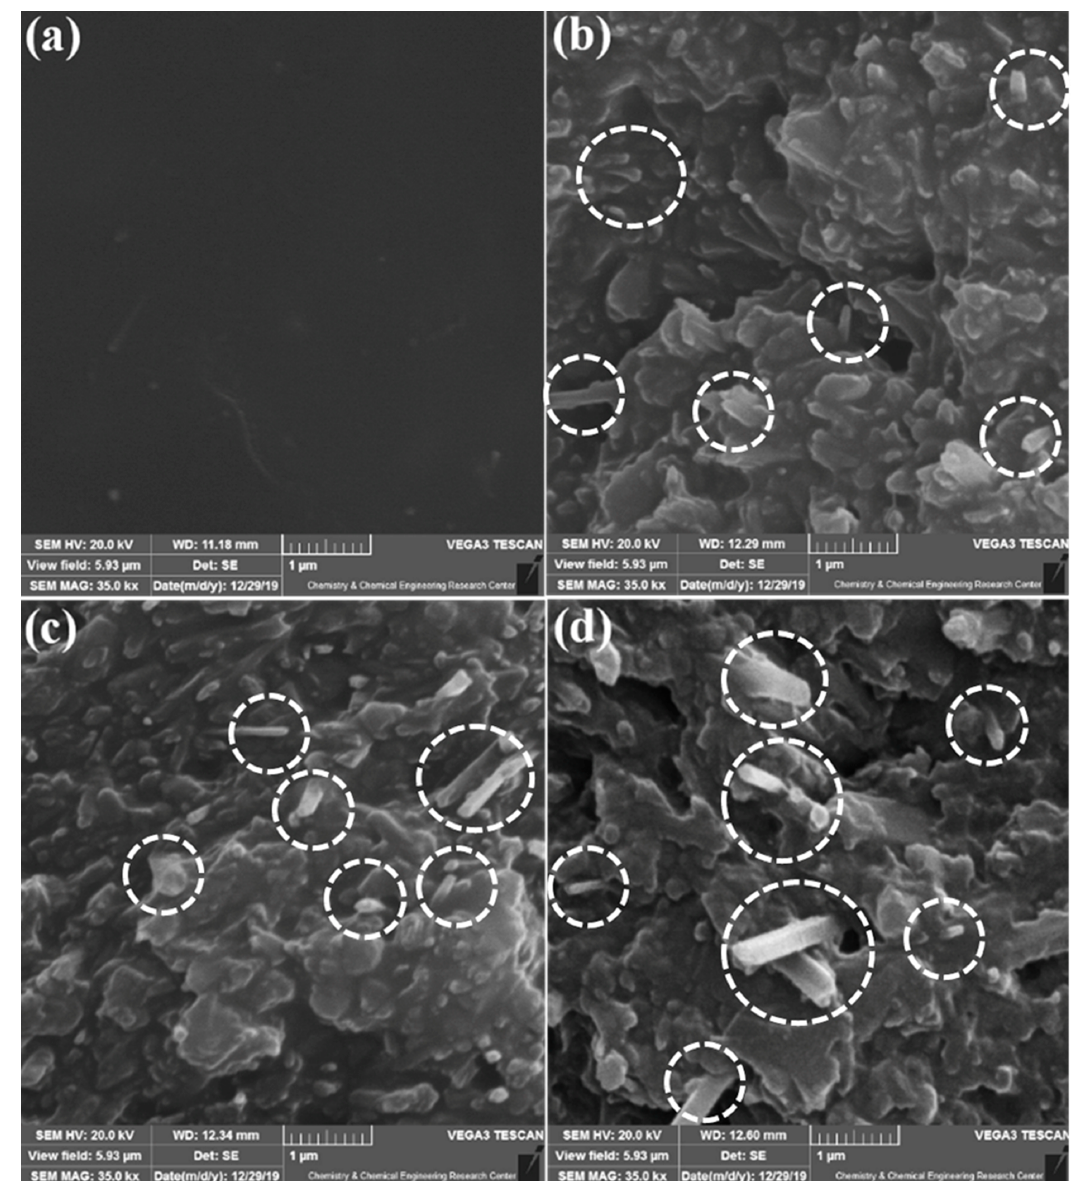
Figure 2. SEM photomicrographs of XNBR/epoxy nanocomposites containing various concentrations of XHNTs ( a ) 0 wt %, ( b ) 3 wt %, ( c ) 5 wt % and ( d ) 7 wt %.